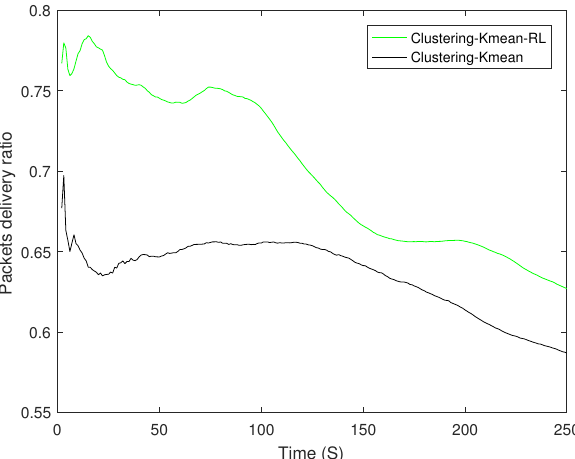
Figure 12. Packet delivery ratio of the reinforcement learning